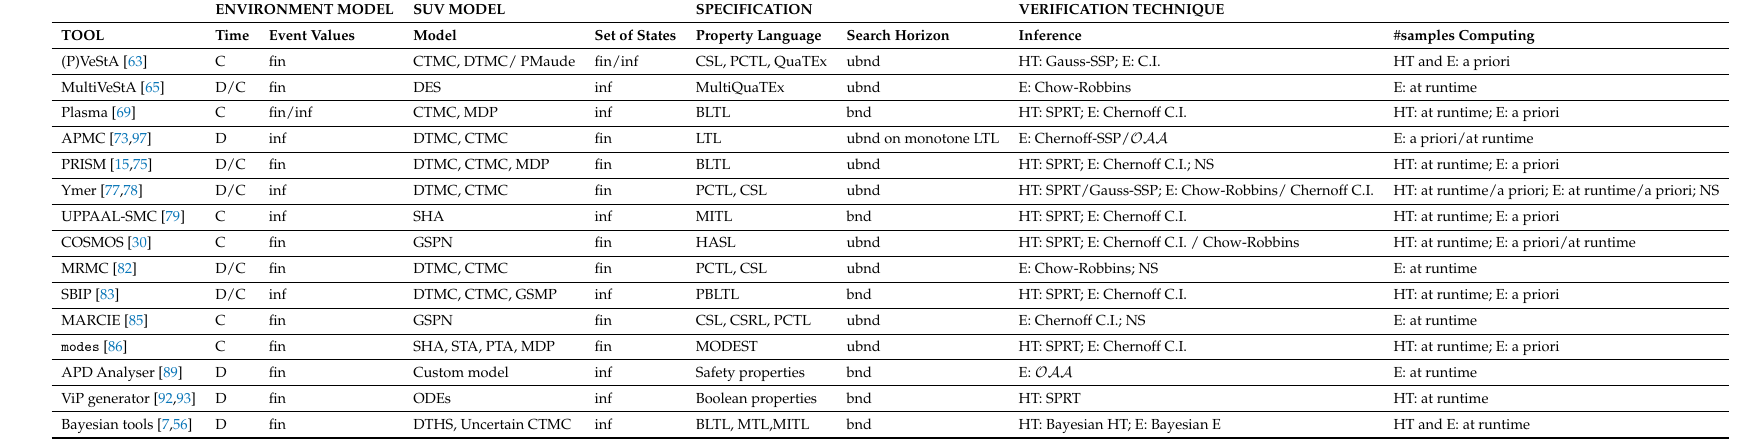
Table 2. Monte Carlo simulation-based SMC tools comparison table. In the Time column D stands for discrete, C for continue. In the column Model , the model is specified as its representation structure or as the language describing the model. In the columns Event values and Set of states , fin means finite and inf means infinite . In the Search horizon column, bnd stands for bounded , ubnd for unbounded . In the Inference column, HT stands for Hypothesis Testing ; E stands for Estimation and NS stands for Numeric-symbolic methods (see Section 3). In the same column, for each inference approach, the name of the algorithm used is specified. For further details about the algorithms, see Table 1. Depending on the algorithm, the number of samples can be computed a priori or at